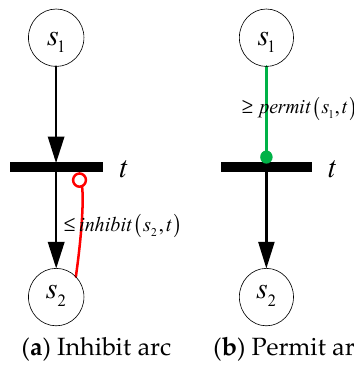
Figure 2. Reading arc and writing arc.